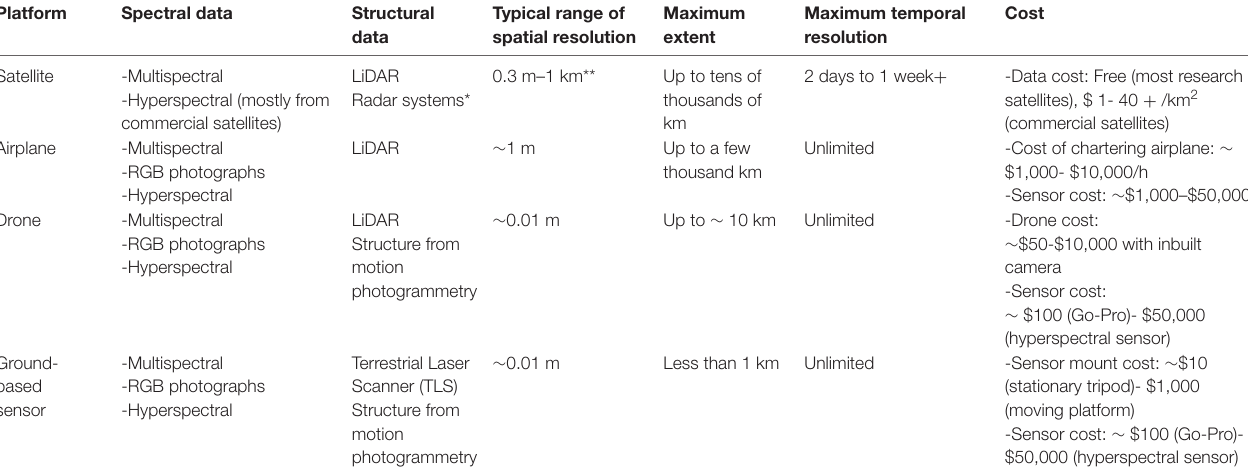
FIGURE 2 | Satellites, airplanes, and drones usually carry sensors that measure flowering vegetation at distinct temporal revisit periods and spatial grains. Typical vegetation features that can be efficiently measured by each of these remote sensing platforms are shown in relation to the temporal and spatial capabilities of each system. TABLE 2 | Examples of the types of data acquired by satellite, airplane, and drone-based imaging platforms, their approximate range of spatial resolutions (at typical flight heights), extents, temporal resolutions and costs to the user.